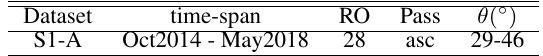
Table 1. Overview of the used SAR stack. S1-A: Sentinel 1-A sensor, RO: relative orbit